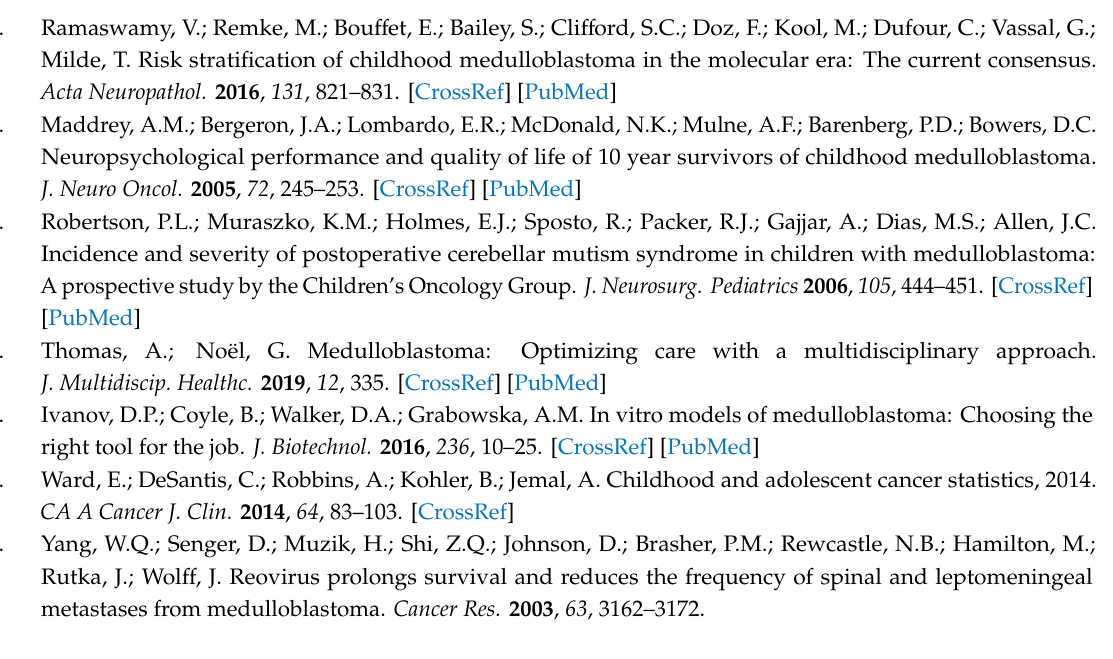
Figure S1: Optimisation of cell density. Cell densities of up to 20,000 cells / well of the D341 cell line were tested. Data represents quantitative relative fluorescence levels of (A) resazurin, and (B) GF-AFC substrate from cells seeded at six di ff erent densities and cultured for 7 days, Figure S2: Optimisation of cell density and culture time. Data represent quantitative relative fluorescence level of (A) resazurin, and (B) GF-AFC substrates from D283 group-3 MB cells seeded at four di ff erent densities and cultured for 7, 10 and 14 days, Figure S3: Optimisation of exposure time. D283 cells were incubated with (A) resazurin, or (B) GF-AFC substrates and analysed at di ff erent time points, Figure S4: Multiplexing resazurin and protease assays. For monoplex detection, D283 cells were incubated with resazurin (6 h) or GF-AFC (3 h) alone. For multiplex detection, cells were incubated with resazurin for 3 h followed by GF-AFC for another 3 h. Plates were analysed for the (A) resorufin signal at 560 / 590 nm excitation / emission and for the (B) GF-AFC signal at excitation / emission wavelength of 380 / 505 nm, Figure S5: Signal distribution across a well using GF-AFC substrate in D341 MB cells. Data are expressed as mean ± standard deviation from three independent assays with four replicates each. (A) Measurements taken from di ff erent sections within one Z-position inside a single, (B) Top versus bottom